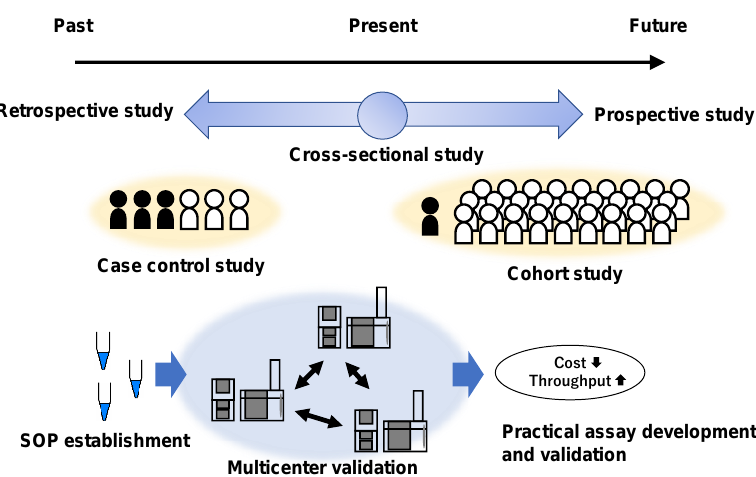
Figure 3. Various study designs used from salivary metabolomics to saliva-based OC test. The top layer describes the general study designs used to identify and validate diagnostic markers. The middle layer describes case-control and cohort studies. The top layer controls the number of OC and non-OC participants, whereas the middle layer includes a low rate of OC owing to the low prevalence rate in the actual cohort. The bottom layer shows the requirements of the saliva-based OC test. SoP establishment and multi-center-level validations are necessary to discover and validate biomarkers using metabolomics. The development and validation of a cost-effective and high-throughput assay that enables targeted analyses of the biomarker is required for clinical use.